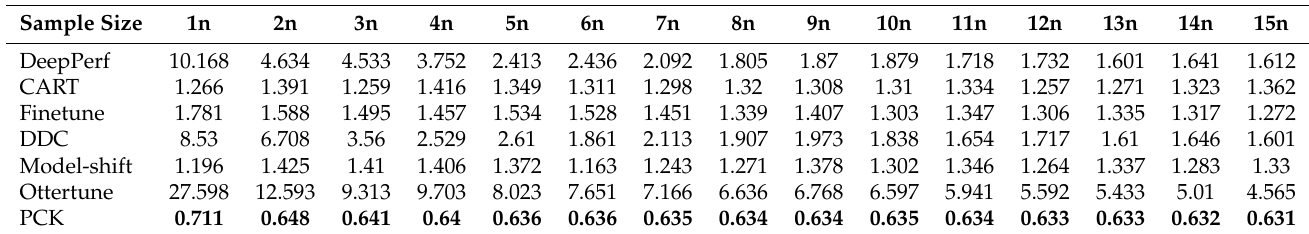
Table 10. MRE comparison among different approaches for Redis (version 5.0.0–6.0.5).